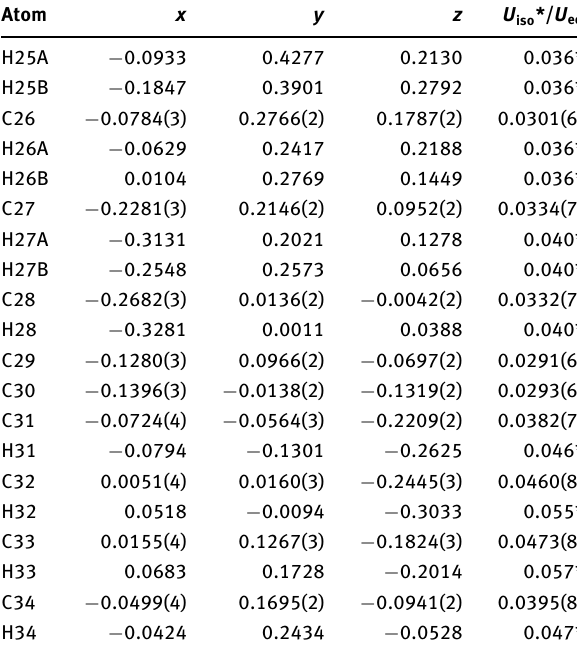
Table 2: Fractional atomic coordinates and isotropic or equivalent isotropic displacement parameters (Å 2